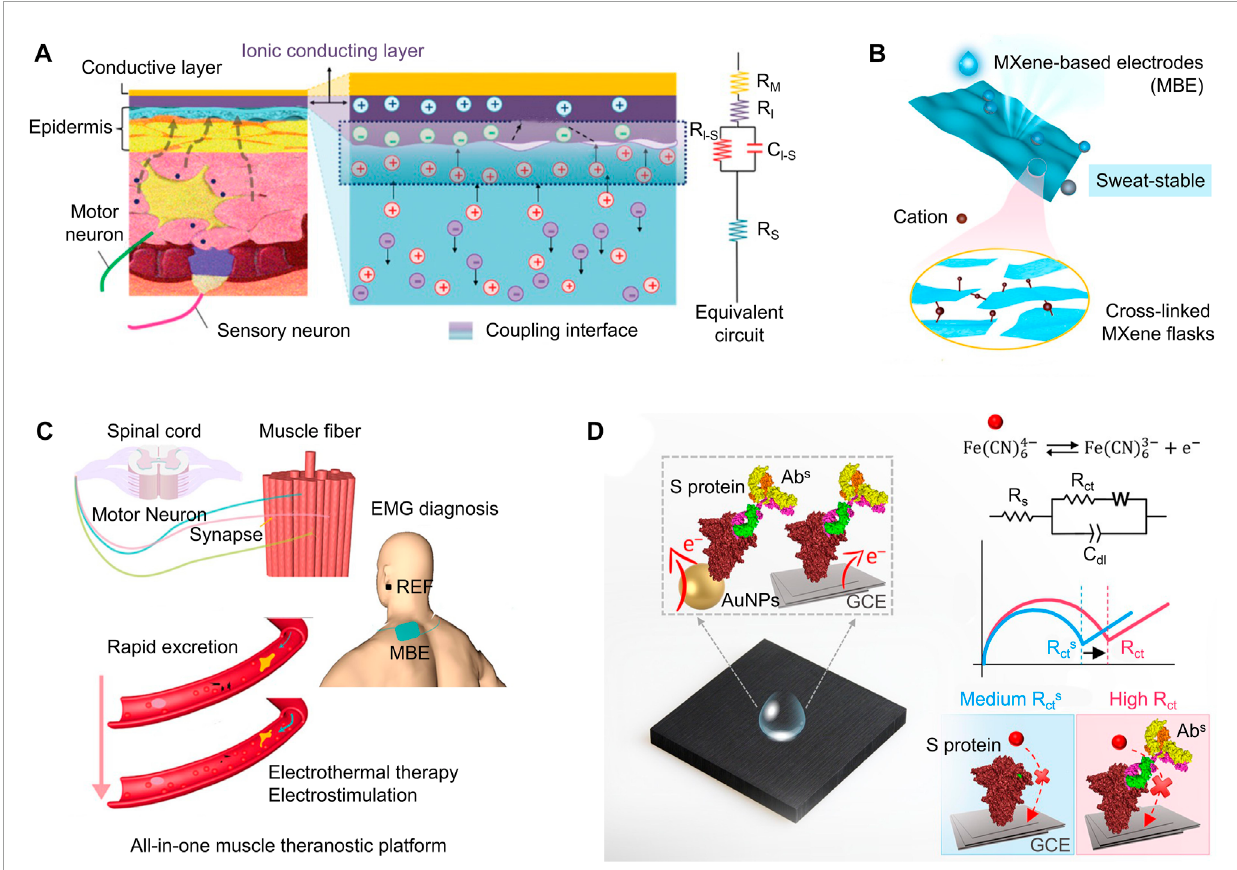
FIGURE 4 (A) A flexible skin-adherent electrode with minimal electrochemical impedance attached attached to the epidermis. An equivalent circuit model is shown to the right. (B) Bioderived, air-permeable, and sweat-stable MXene-based electrode (top), where structural crosslinking exists throughouth